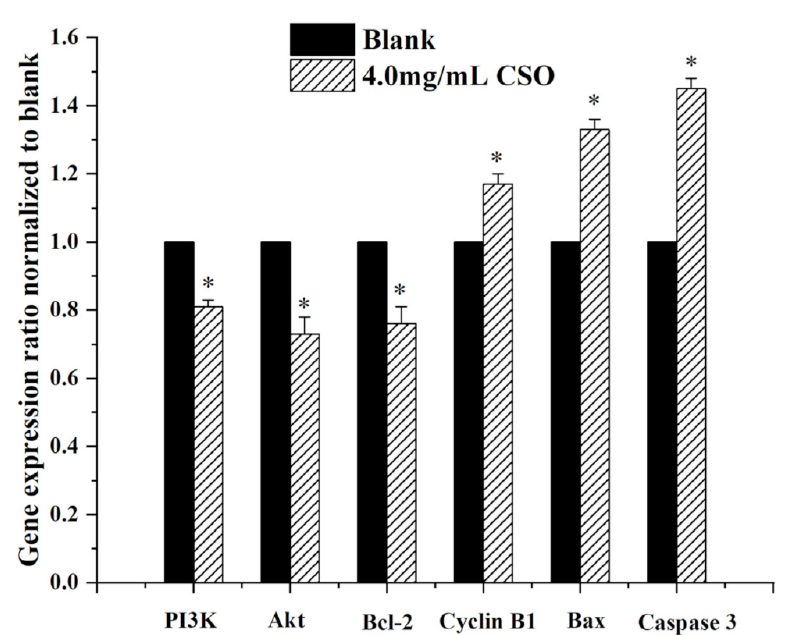
Figure 6. Impact of CSO on PI3K, AKT, Bcl-2, cyclin B1, Bax, and caspase-3 in HT-29 cells; * p < 0.05, vs. the